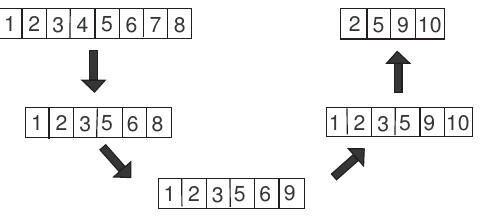
Figure 3. Example of a path created between two solutions S i = { 1,2,3,4,5,6,7,8 } and S g = { 2,5,9,10 }